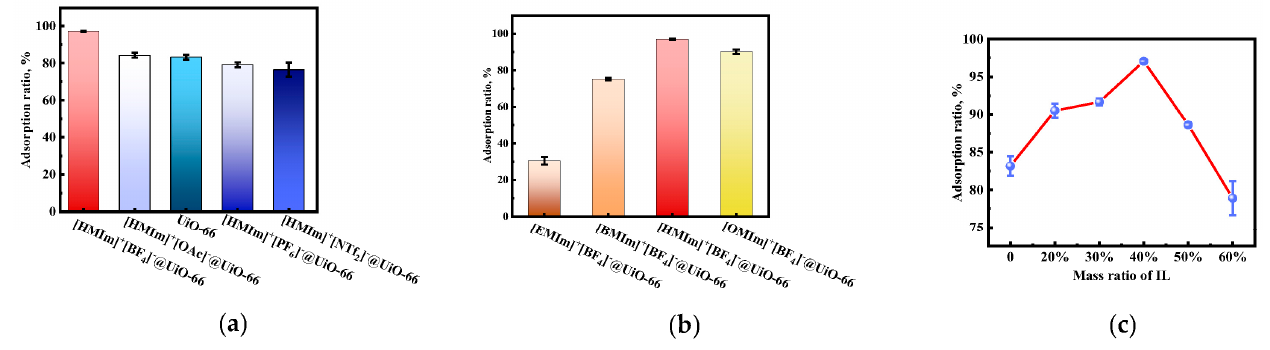
Figure 1. ( a ) IL cation dependence of adsorption ratio; ( b ) IL anion dependence of adsorption ratio( c Au(III) = 60 mg/L, V Au(III) = 10 mL, m [HMIm]+[BF4] − @UiO − 66 = 10 mg, t = 6 h, T = 35 °C, pH = 2); ( c ) mass ratios of [HMIm] + [BF 4 ] − (c Au(III) = 60 mg/L, V Au(III) = 10 mL, m [HMIm]+[BF4] − @UiO − 66 = 10 mg, t = 6 h, T = 35 °C, pH = 2).